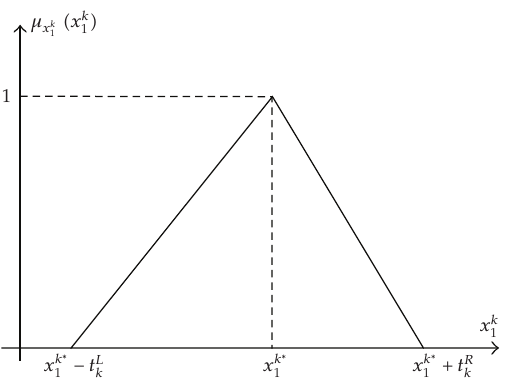
Figure 2: Membership function of decision vectors x k